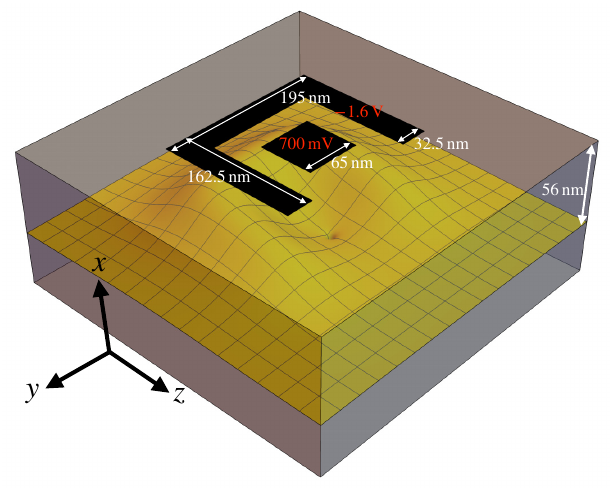
FIG. 7. Surface gate architecture (black) and electron confine- ment potential − e (cid:15) in the donor plane generated by the gates and the ionized donor. The gate voltages are chosen as indicated. The origin of the coordinate system is set below the center of the quadratic gate at the bottom of the gate layer and the axes are as shown in the